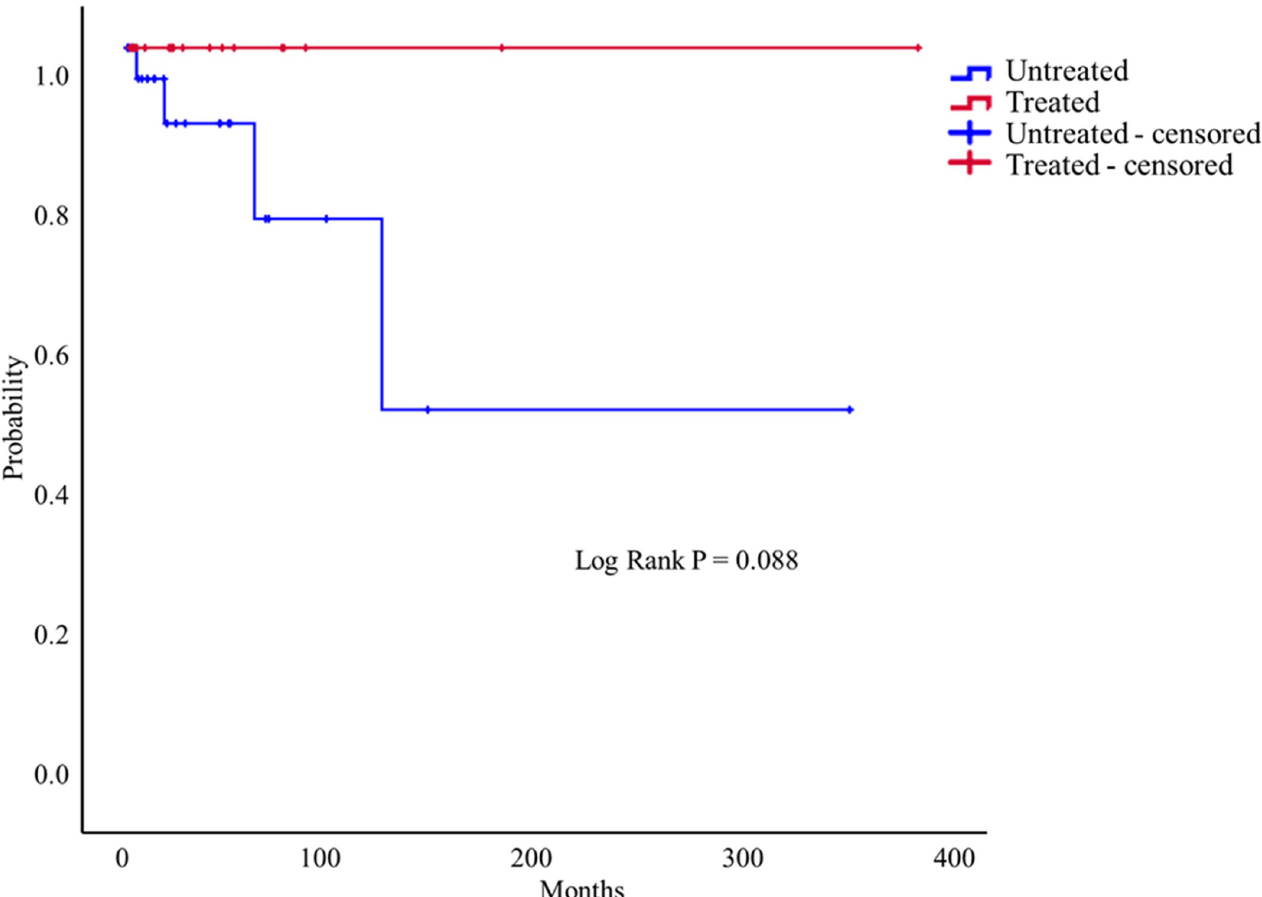
Fig 2. Kaplan–Meier curve illustrating the time without the development of new cerebral complications associated with PAVM treatment.